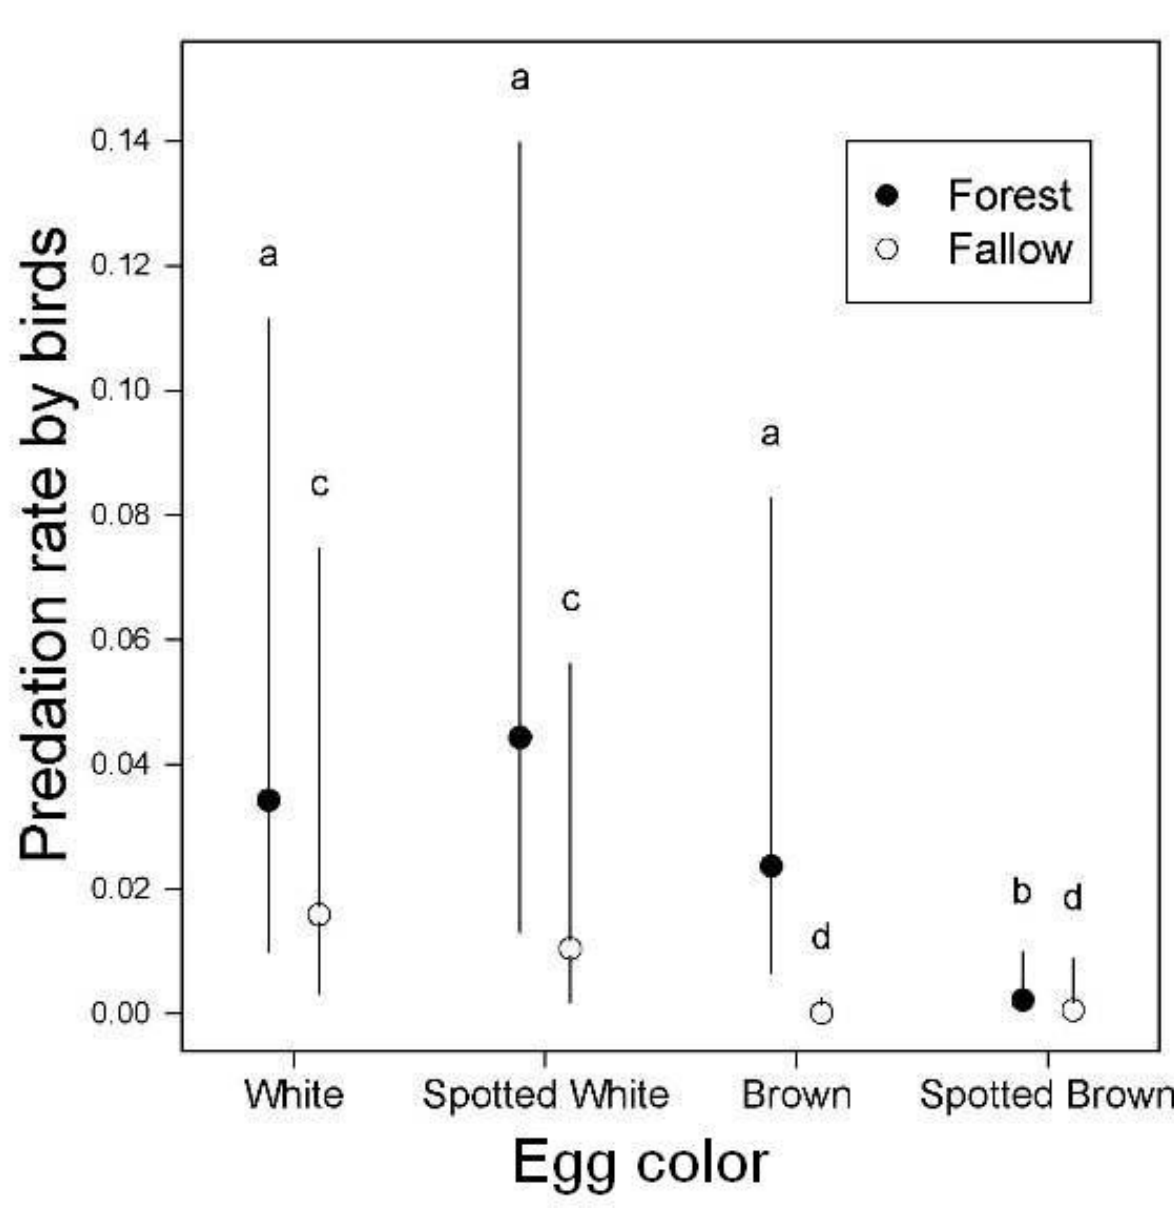
Fig. 1. Predation rates by birds in different landscapes as predicted by logistic regression. Different lowercase letters indicate significant differences among groups (LSMEANS function in Statistical Analysis Software, p < 0.05). Bars, standard